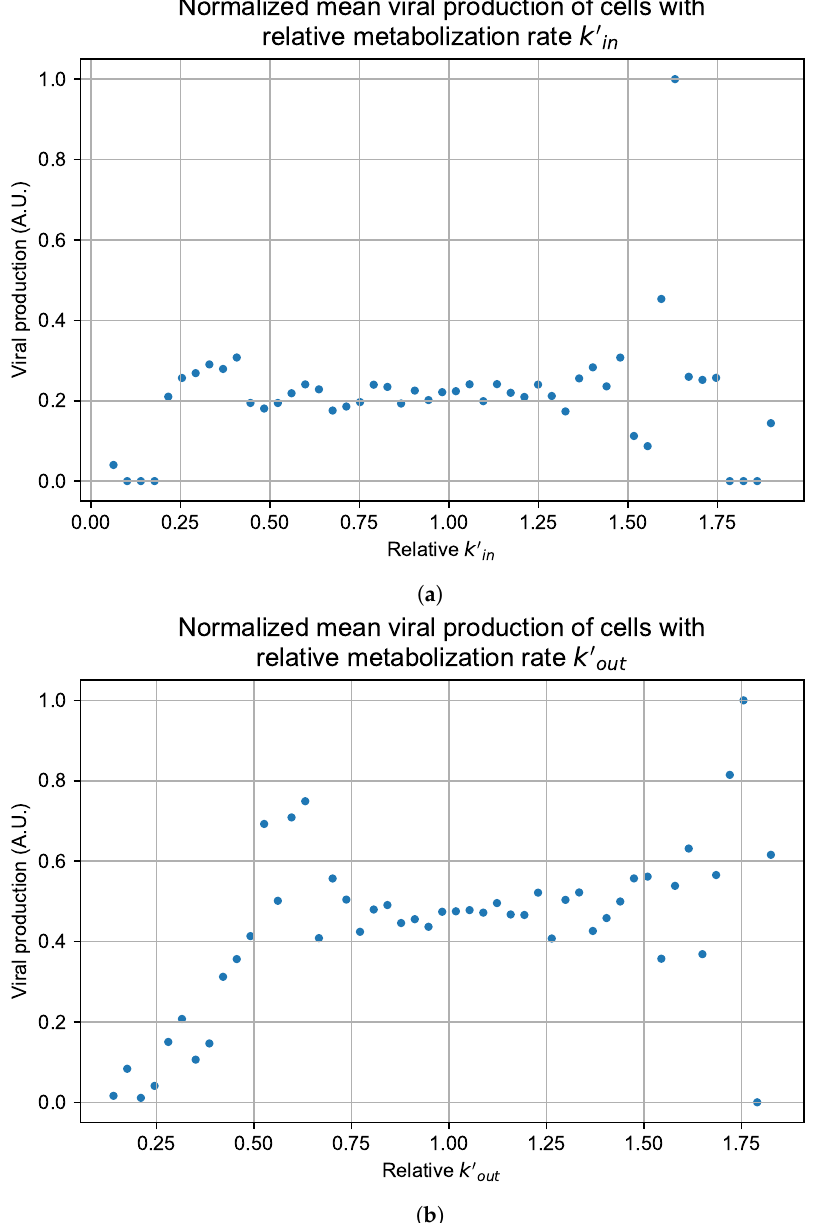
Figure A127. Mean viral production of cells versus their metabolism rates normalized by the maxi- mum mean production with widespread infection parameters. ( a ) Results for simulations varying only k in . ( b ) Results for simulations varying only k out